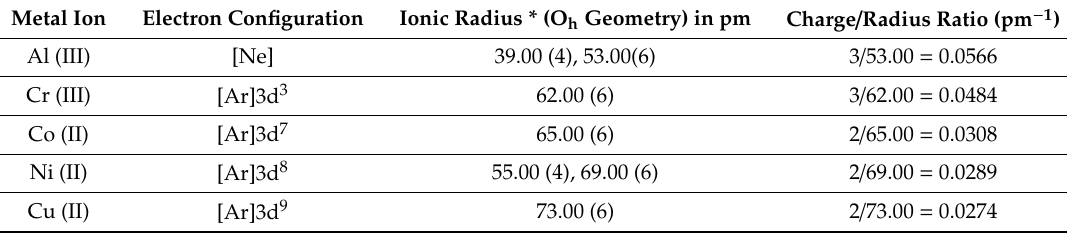
Table 1. Charge to radius ratio of di ff erent